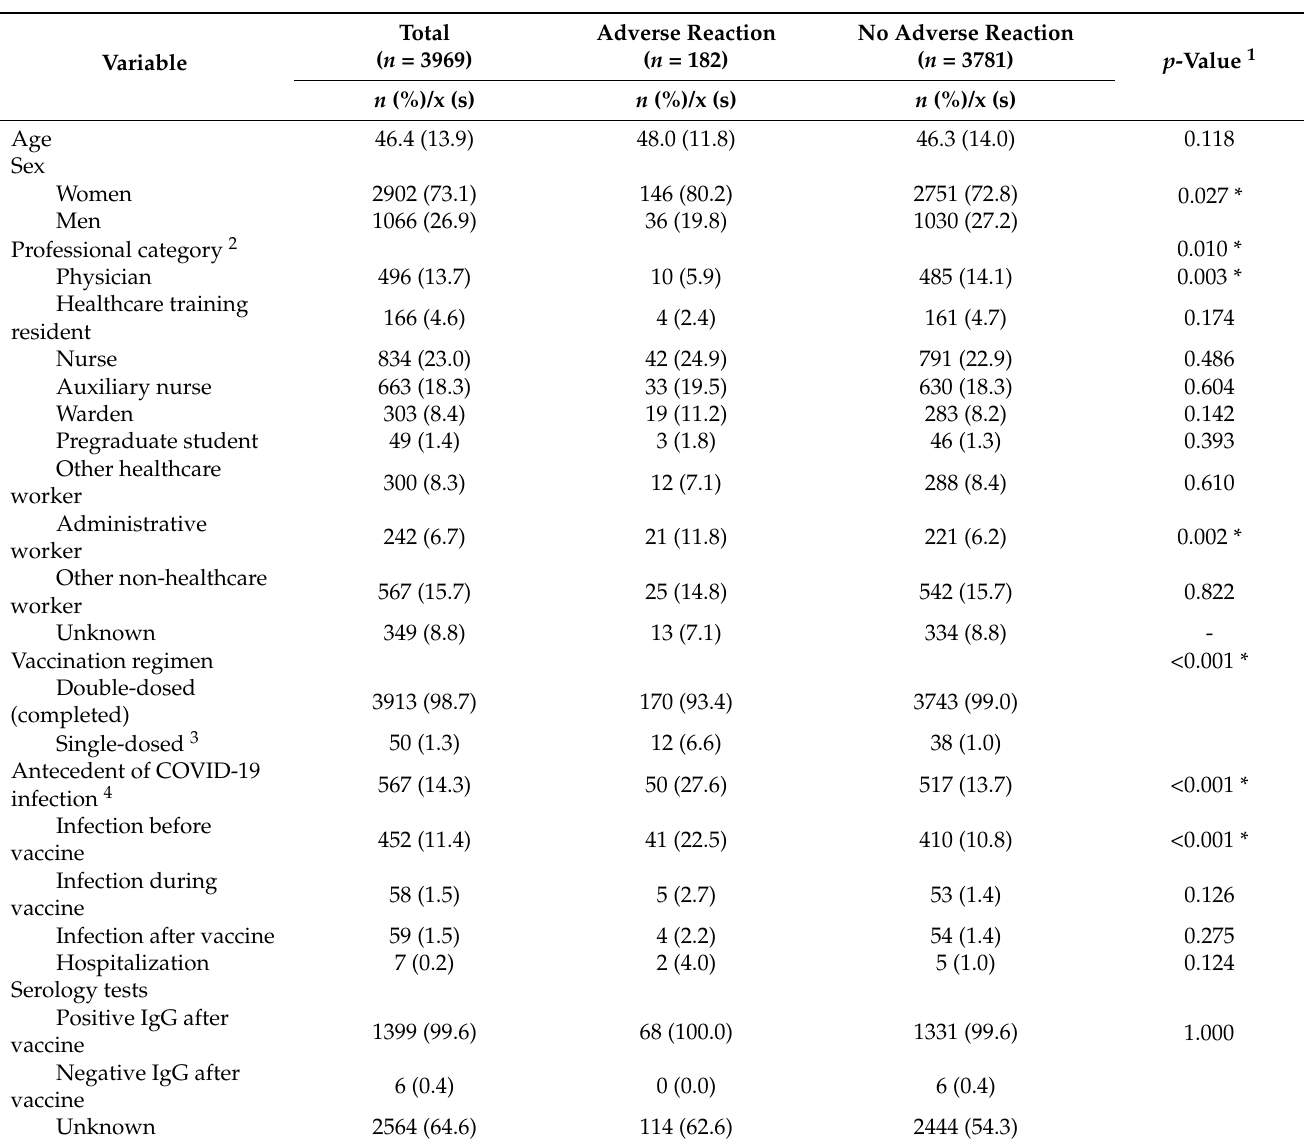
Table 1. Sociodemographic and clinical characteristics stratified by the presence of reported ad- verse